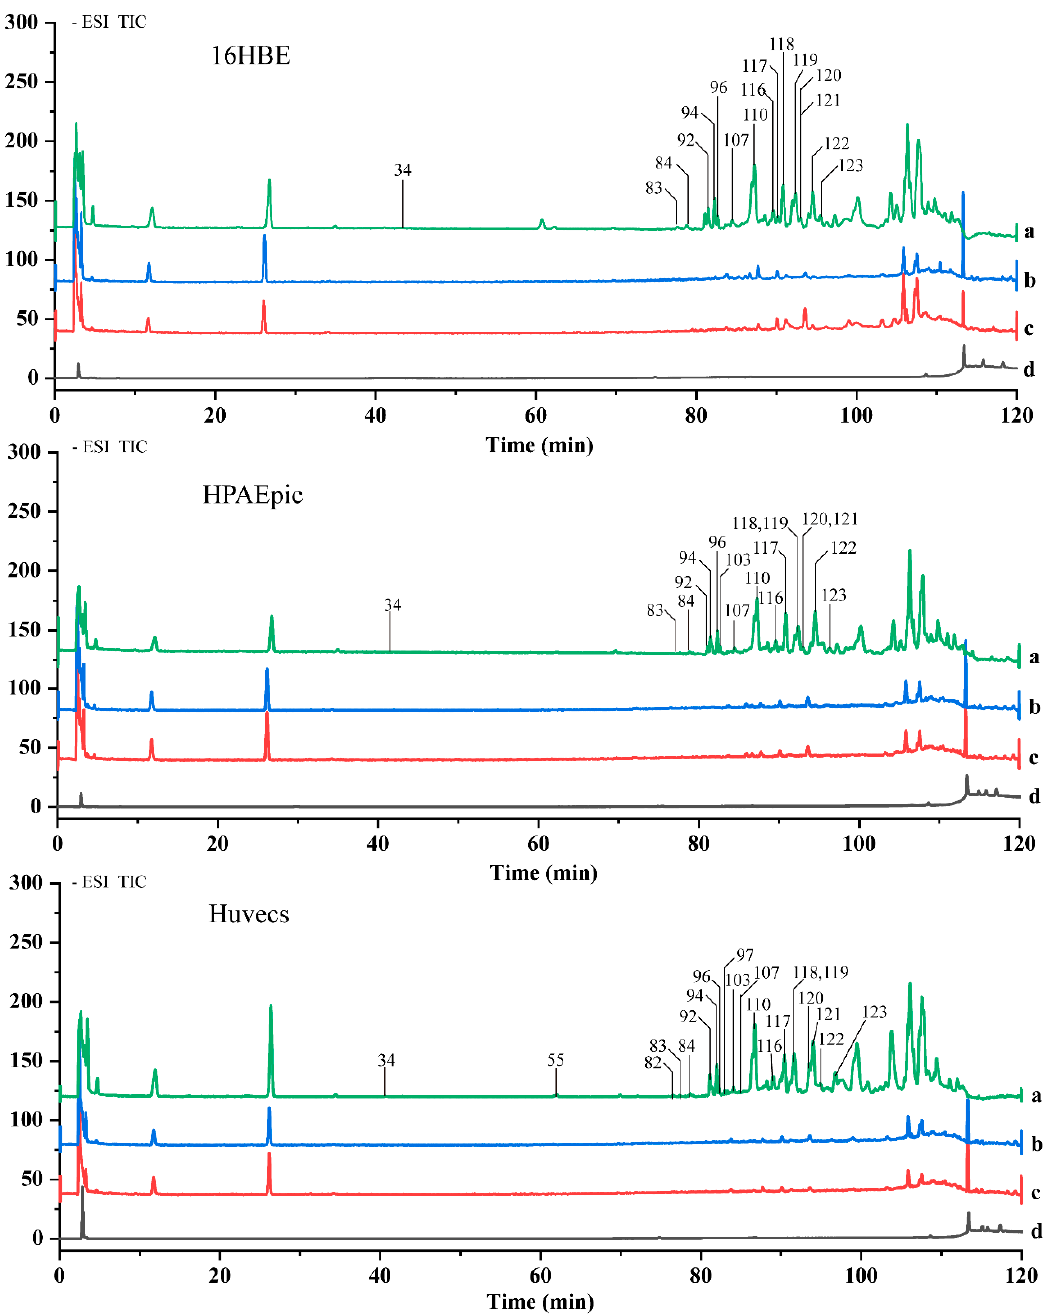
Figure 3. The total ion chromatograms (TICs) of EDG 16HBE, HPAEpiCs and HUVECs ‐ binding molecules obtained with HPLC ‐ Q ‐ TOF/MS in negative ion mode. a: LPS+EDG group, target cells cultured with LPS (5 μ g/mL) and EDG extraction (20 μ g/mL); b: LPS group, target cells cultured with LPS (5 μ g/mL); c: control group, target cells cultured with serum ‐ free medium; d: final washing eluate group. P34: 26 ‐ O ‐ β ‐ D ‐ glucopyranosyl ‐ (25 R ) ‐ 5 β ‐ furostane ‐ 3 β ,22 α ,26 ‐ triol ‐ 3 ‐ O ‐ β ‐ D ‐ xylopyra ‐ nosy ‐ l ‐ (1 → 4) ‐ β ‐ D ‐ glucopyranosyl(1 → 2) ‐ β ‐ D ‐ glucopyranoside, P55: Ruscogenin 3 ‐ O ‐ α ‐ L ‐ rham ‐ nopy ‐ ranosyl (1 → 2) ‐ [ β ‐ D ‐ glucopyranosyl(1 → 3)] ‐ O ‐ β ‐ D ‐ glucopyranoside, P82: Ophiopogenin ‐ 3 ‐ O ‐ α ‐ L ‐ rham ‐ npyranosyl ‐ (1 → 2) ‐ β ‐ D ‐ xylopyranosyl ‐ (1 → 3) ‐ β ‐ D ‐ glucopyranoside, P83: Cixi ‐ ophiopog ‐ on C, P84: (25 R ) ‐ 3 β ‐ [( O ‐ β ‐ D ‐ glucopyranosyl ‐ (1 → 4) ‐ β ‐ D ‐ galactopyranosyl)oxy] ‐ 5 β ‐ spirostan ‐ 12 ‐ one, P92: Pennogenin 3 ‐ O ‐ α ‐ L ‐ rhamnopyranosyl ‐ (1 → 2) ‐ β ‐ D ‐ xylopyranosyl ‐ (1 → 4) ‐ β ‐ D ‐ glucopy ‐ ra ‐ noside, P94: Prazerigenin A 3 ‐ O ‐ α ‐ L ‐ rhamnopyranosyl ‐ (1 → 2) ‐ β ‐ D ‐ glucopyranoside, P96: Ophi ‐ opogonanone E, P97: Prazerigenin A ‐ 3 ‐ O ‐ α ‐ L ‐ rhamnopyranosyl ‐ (1 → 3) ‐ β ‐ D ‐ xylopyranosyl ‐ (1 → 4) ‐ β ‐ D ‐ glucopyranoside, P103: 5,7,2’ ‐ Trihydroxy ‐ 3’,4’ ‐ methylenedioxy ‐ 6,8 ‐ dimethyl homois ‐ oflavone, P107: (25 S ) ‐ 3 β ‐ [( O ‐ α ‐ L ‐ rhamnopyranosyl ‐ (1 → 2) ‐ β ‐ D ‐ galactopyranosyl)oxy] ‐ 5 β ‐ spiros ‐ tan ‐ 12 ‐ one,